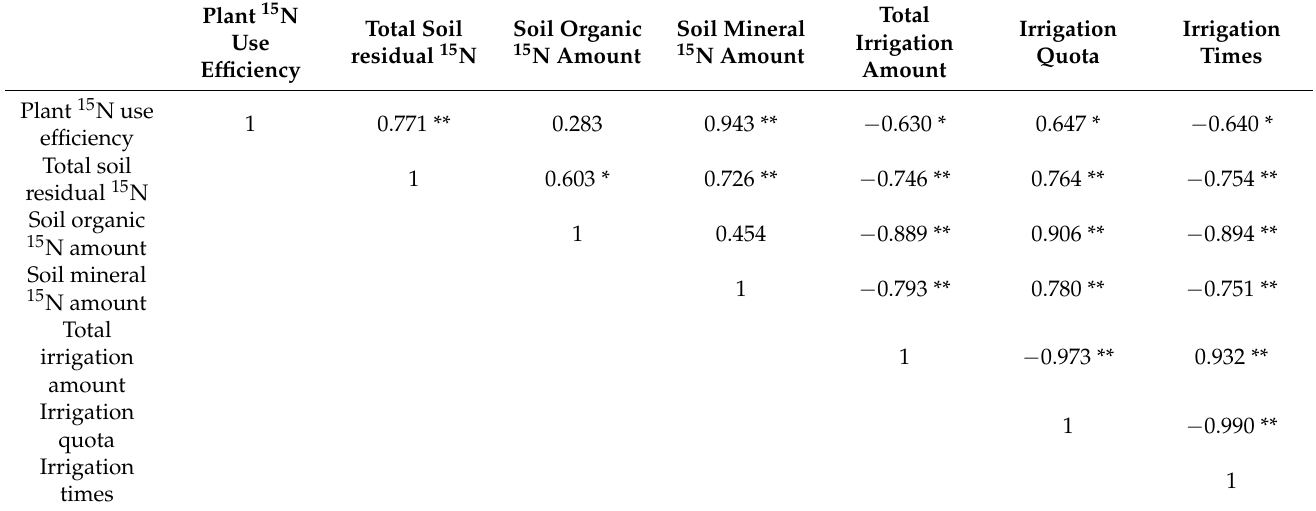
Note: ** and * in the table indicate significant correlation at the levels of 0.01 and 0.05, respectively.